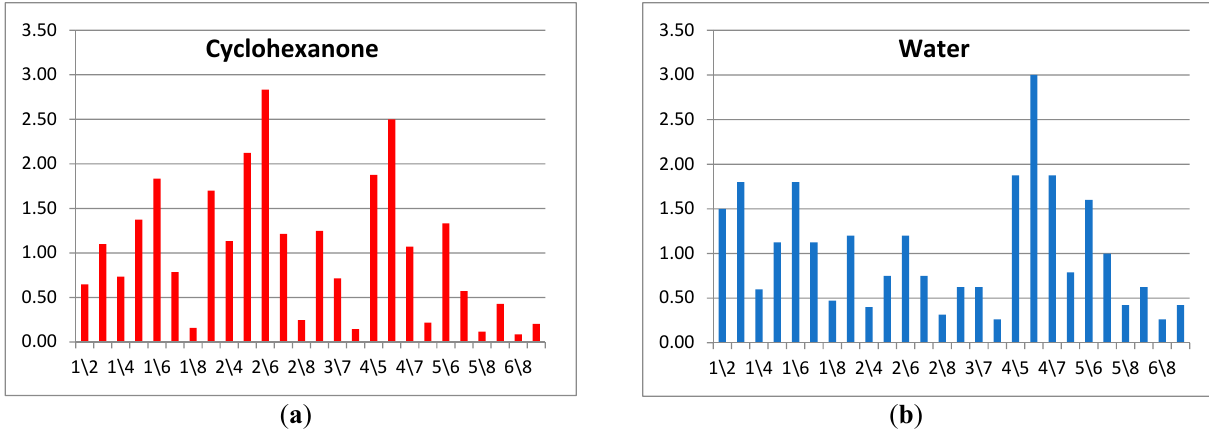
Figure 3. Spectra of A(i/j) cross mass-sensitivity parameters for vapors of ( a ) cyclohexanone and ( b ) distilled water.